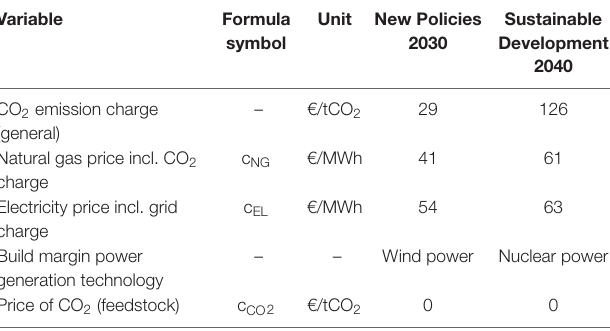
TABLE 5 | Cost factors generated with the ENPAC tool based on the two IEA World Energy Outlook 2018 scenarios “New Policies” and “Sustainable Development” (Pettersson et al., 2020).